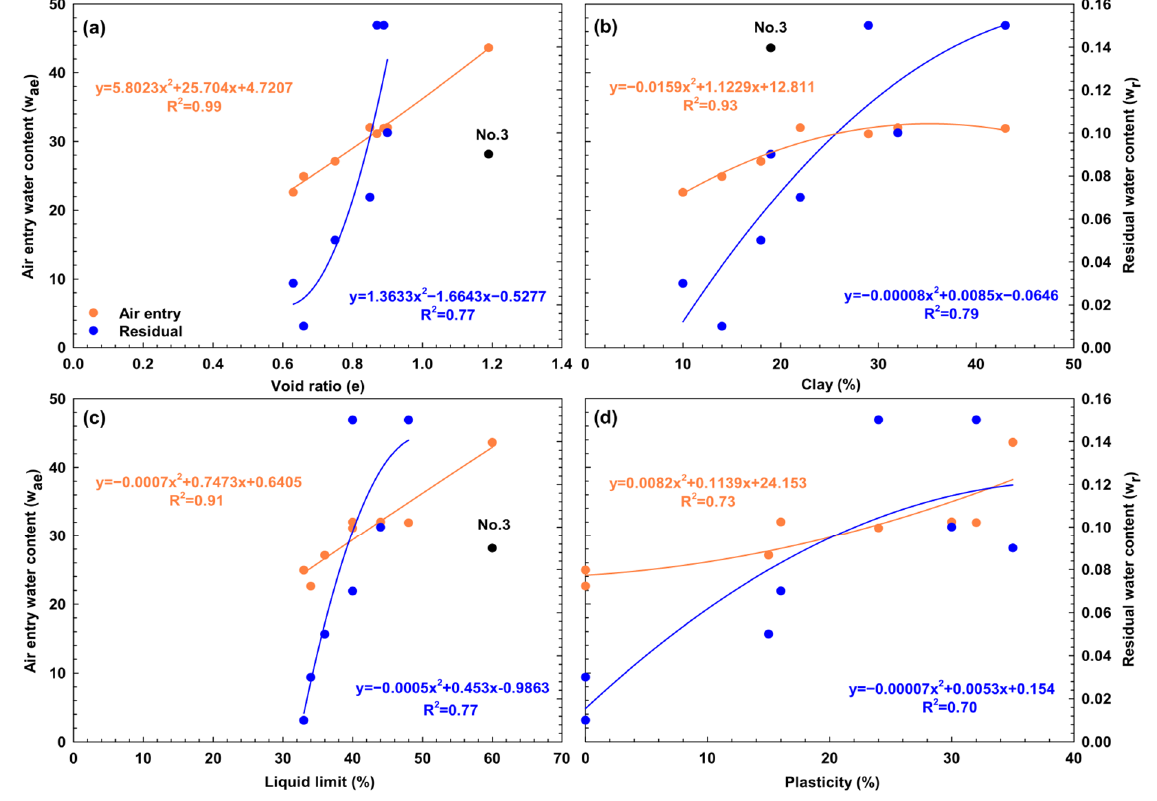
Figure 9. Relationship between SWCC water contents and soil properties: ( a ) void ratio, ( b ) clay (%), ( c ) liquid limit (%), ( d ) plasticity (%).